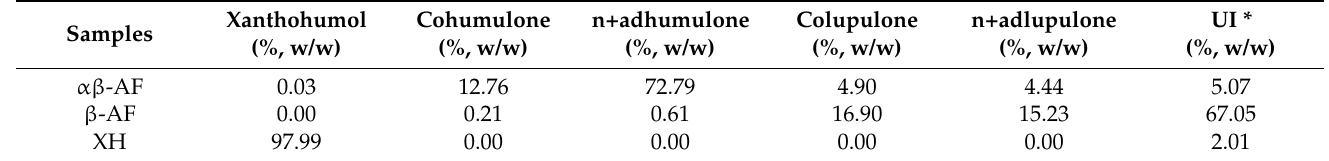
Table 3. The chemical composition of pure components/purified extracts included in our experiment, evaluated by